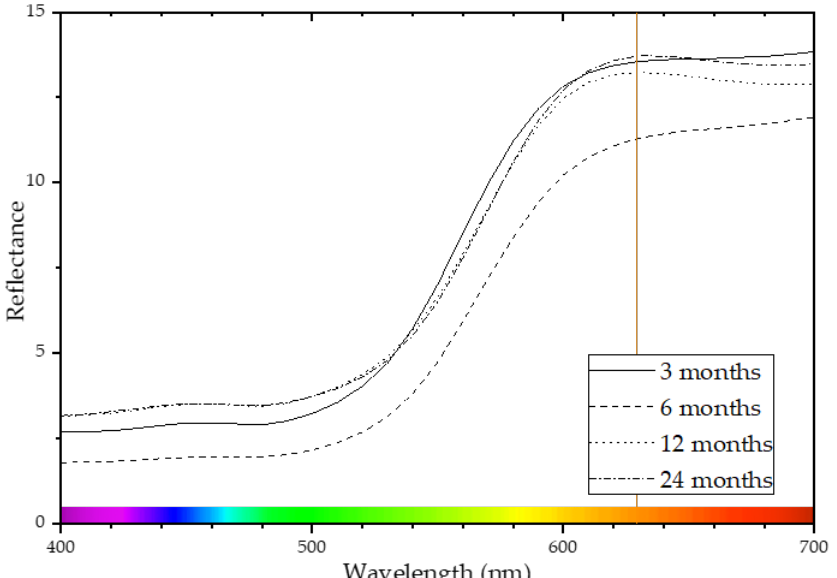
Figure 5. The reflectance spectra of the natural patina developed after different times of exposure to the Madrid atmosphere.